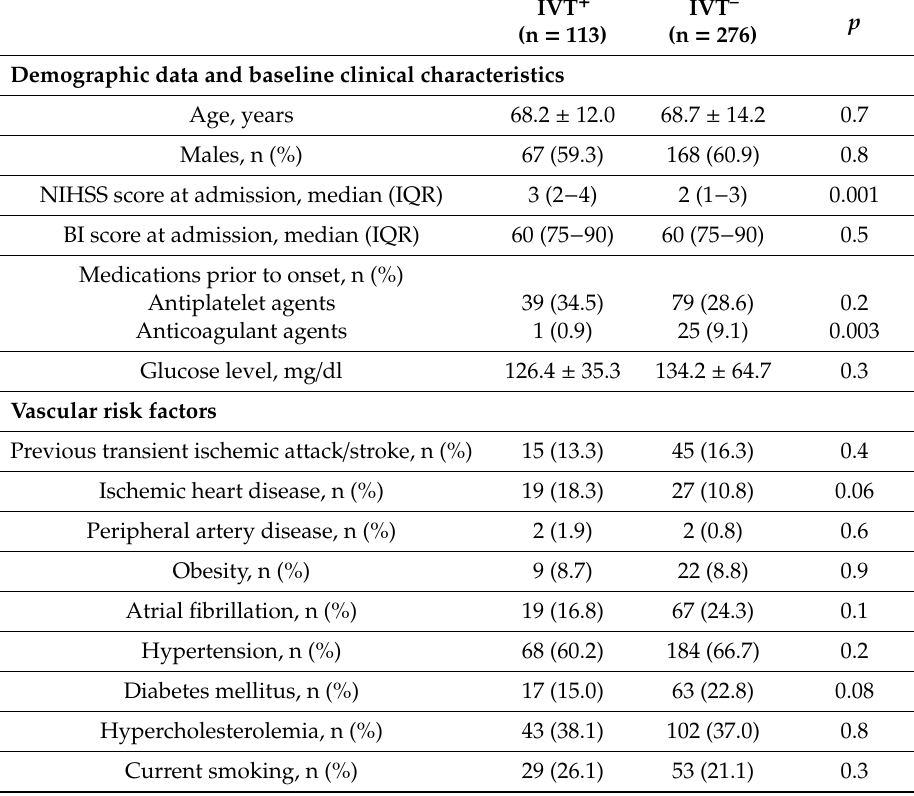
Table 1. Baseline characteristics.